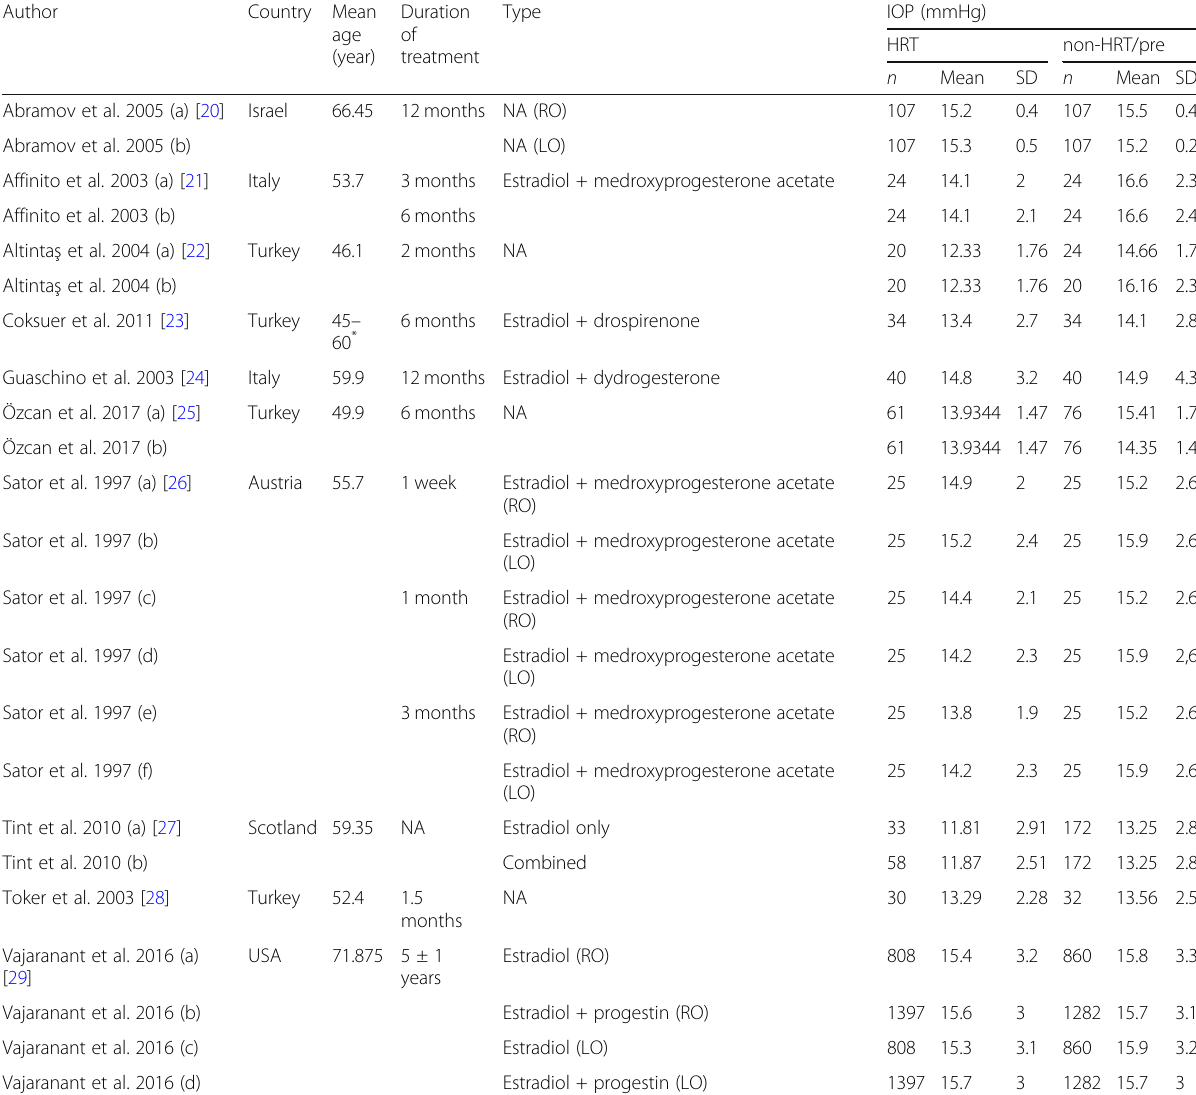
Table 1 Summary of the studies for the IOP between HRT-treated patients and the control subjects